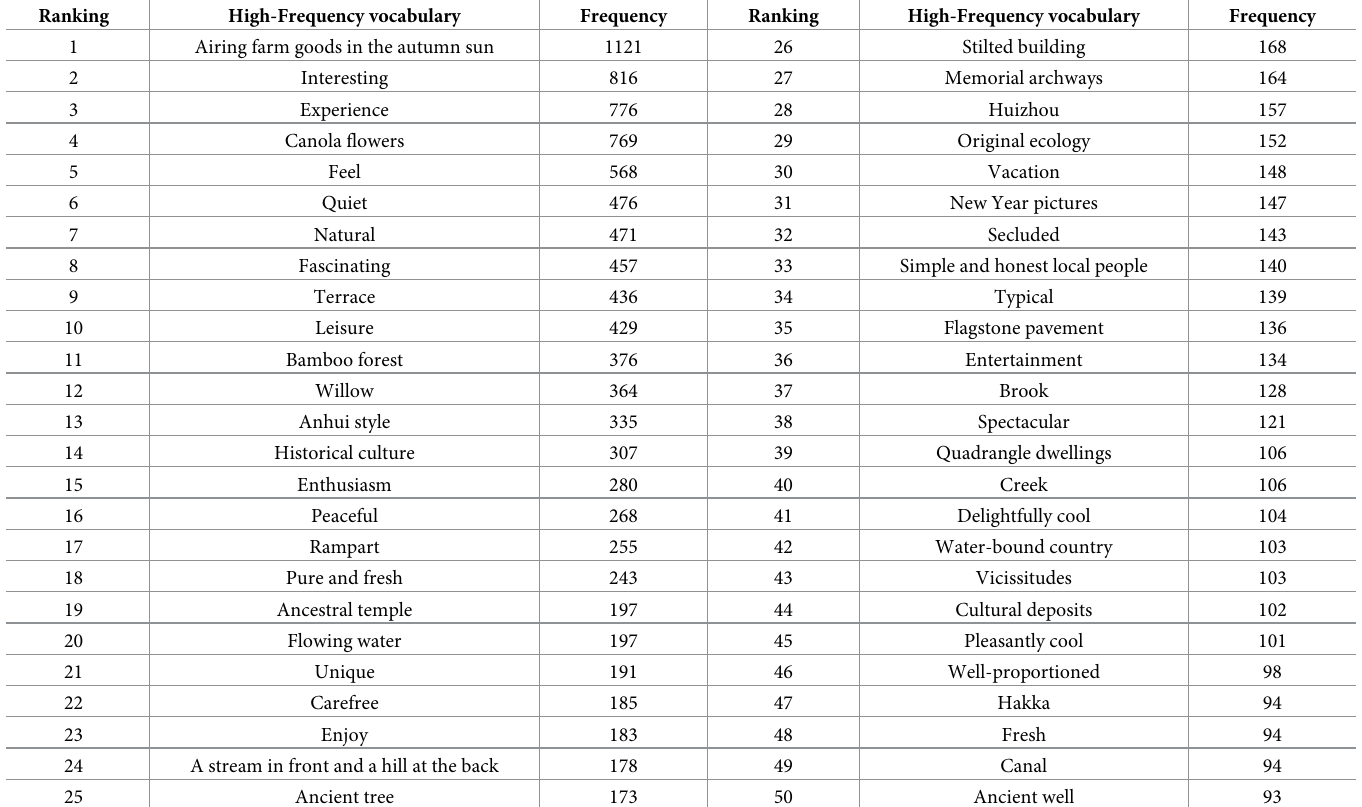
Table 3. High-frequency vocabulary in traditional settlement culture